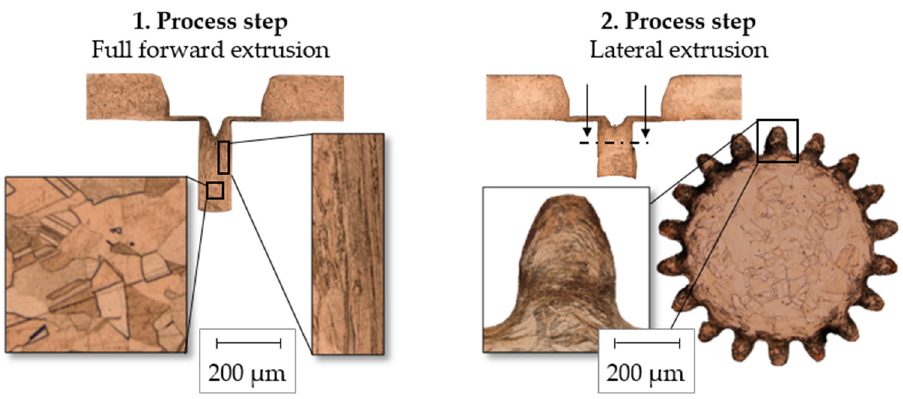
Figure 6. Resulting grain structure.